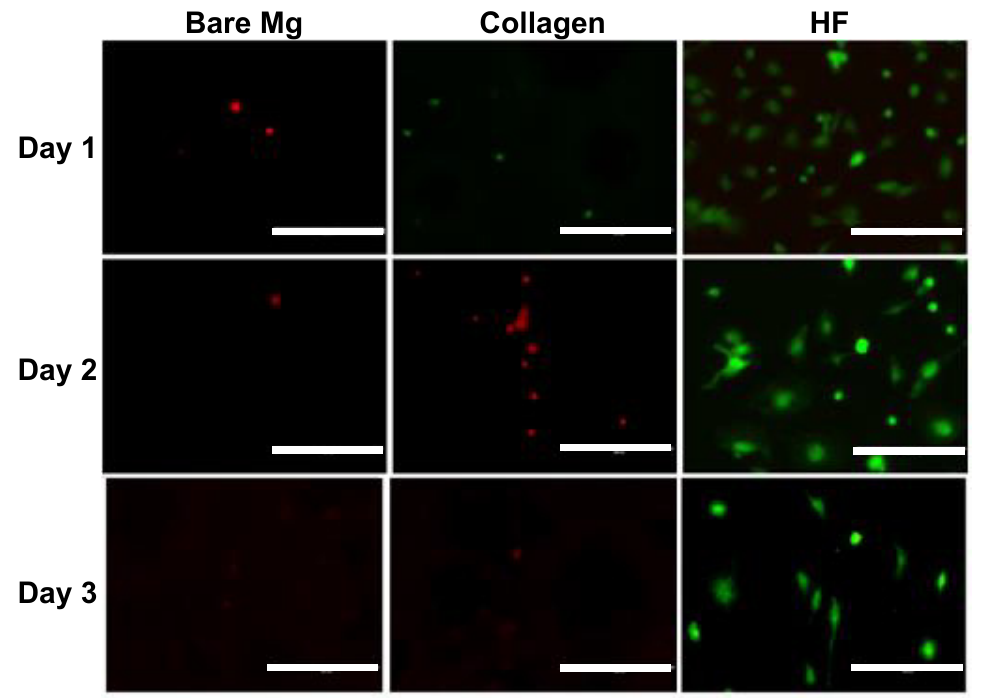
Figure 6. Endothelial cells cultured on bare Mg, collagen coated Mg, and HF treated Mg from day 1 to day 3 (Scale bar: 10